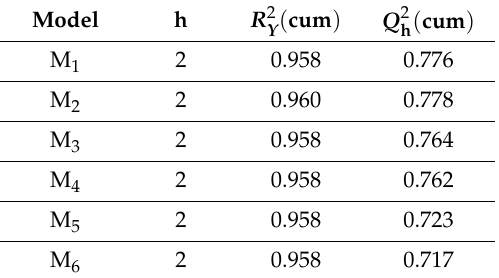
Table 3. Validation results of M 1 –M 6 .